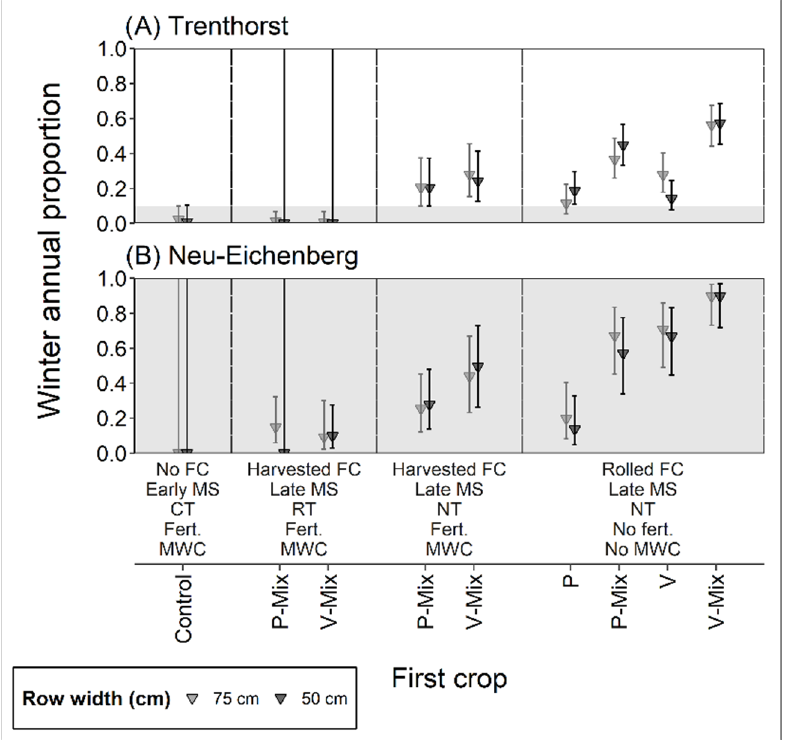
Figure 4. Winter annual proportions at the two locations averaged over year . The x-axis shows the first crop factor (P = winter pea, V = hairy vetch, P-Mix = winter pea and cereal mixture, V-Mix = hairy vetch and cereal mixture) grouped by management (FC = first crop, MS = maize sowing, CT = conventional tillage, RT = reduced tillage, NT = no tillage, Fert. = fertilization, MWC = mechanical weed control). Row width is indicated by colours. Error bars represent the 95% CI of the estimates after multivariate t adjustment. The grey background indicates the 95% CI of the 75 cm SCS for a better comparison. Please note that for treatments with only zero observations, the model estimates the full possible range (0–1) as CI. Additionally, DCS NT treatments at TRE were only in the second year